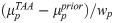
Effects of the model parameters on the features of detected TAAs in the spreading seizure model in the noisy variant.(A) Upper plot shows the slope of linear regression sp,f between all parameters and features, normalized by the parameter range width wp and standard deviation σf of the feature sp,f
wp/σf. Lower plot shows the normalized change in parameter mean for detected TAAs and the prior distribution, (μpTAA−μpprior)/wp, indicating shift of the parameter density to higher/lower values. More saturated blue (red) elements indicate stronger positive (negative) relation. Labeled regions are analyzed in other panels. (B) Relation between the spread velocity and duration of the TAAs and slope of the TAA spread. Solid line and points represent the mean of the features, the shaded area is the 10-90 percentile range. (C) Relation between the frequency and wave velocity and variance explained by the first one and first two components. In the upper plots, black contours indicate the wavelength = wave velocity / frequency. The relation between the features and the wavelength is shown in the lower panels. (D) Relation between the frequency and wave velocity and the density of detected TAAs. The number of detected TAAs decreases with shorter wavelength (left panel) as well as with the frequency alone (right panel).